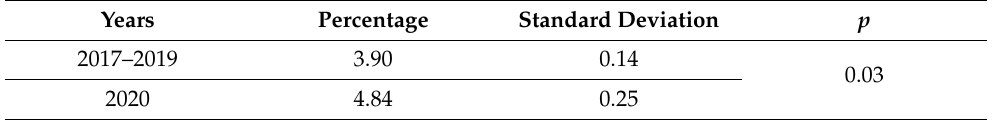
Table 4. Mortality among patients with DFU in 2017–2019 in comparison with